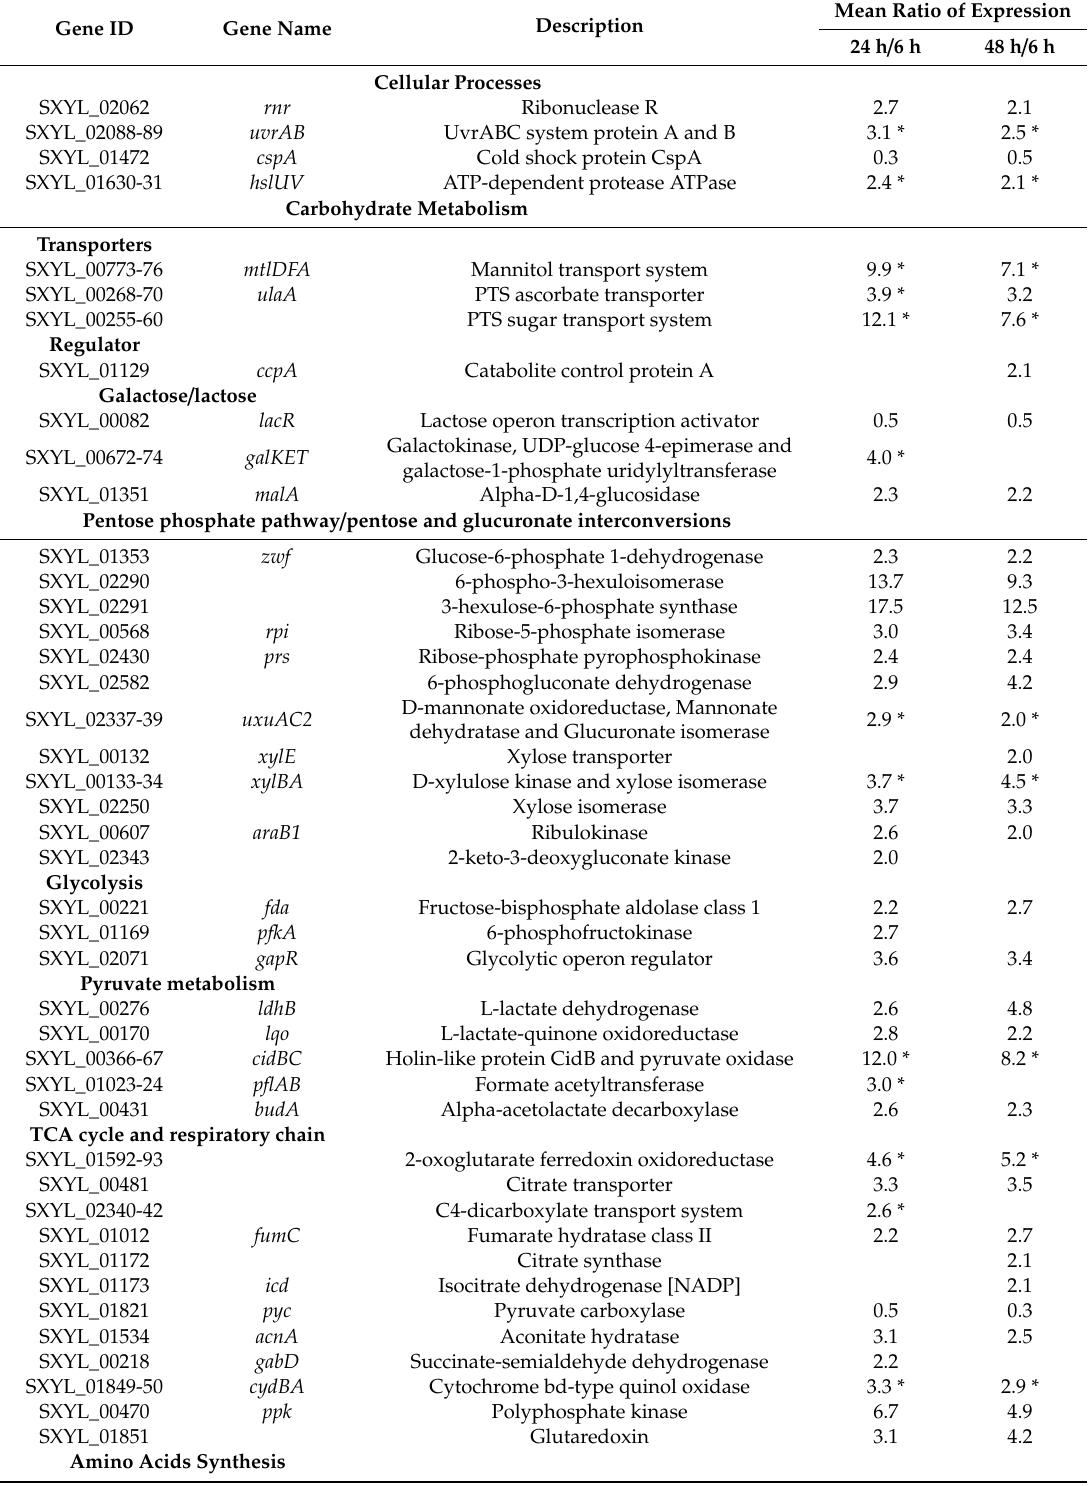
Table 1. Genes of Staphylococcus xylosus di ff erentially expressed at 24 h and / or 48 h compared to 6 h in the dairy matrix